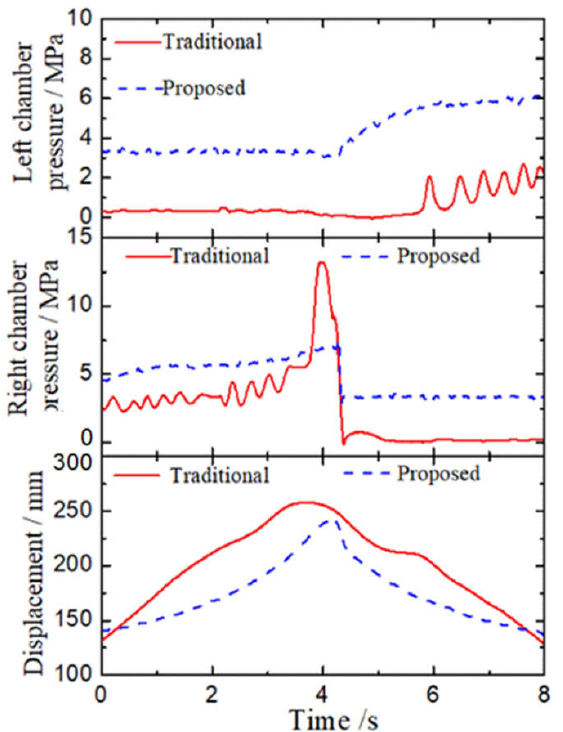
Figure 10. Test curves of the traditional system and the proposed system under zero-load conditions.